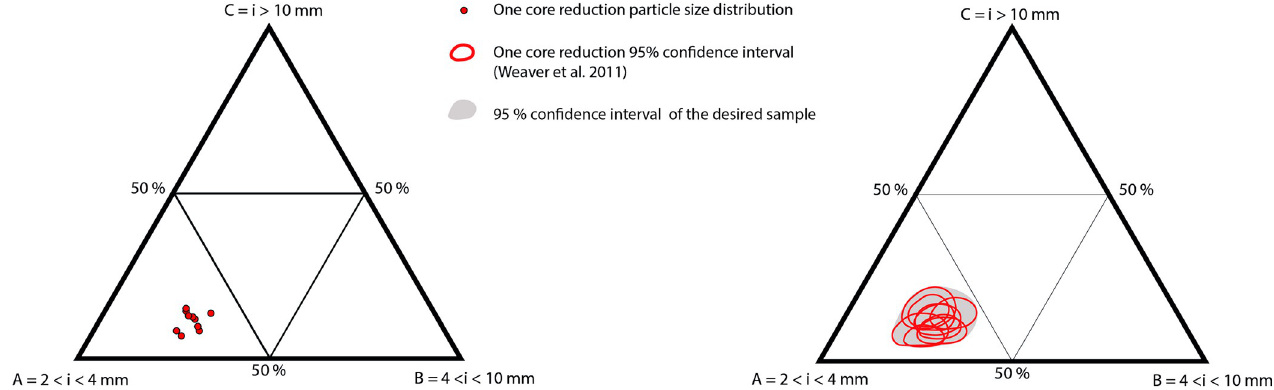
Fig 4. Illustration of how we applied the Weaver et al. (2011) method to create 95% confidence ellipse intervals in the ternary plots.